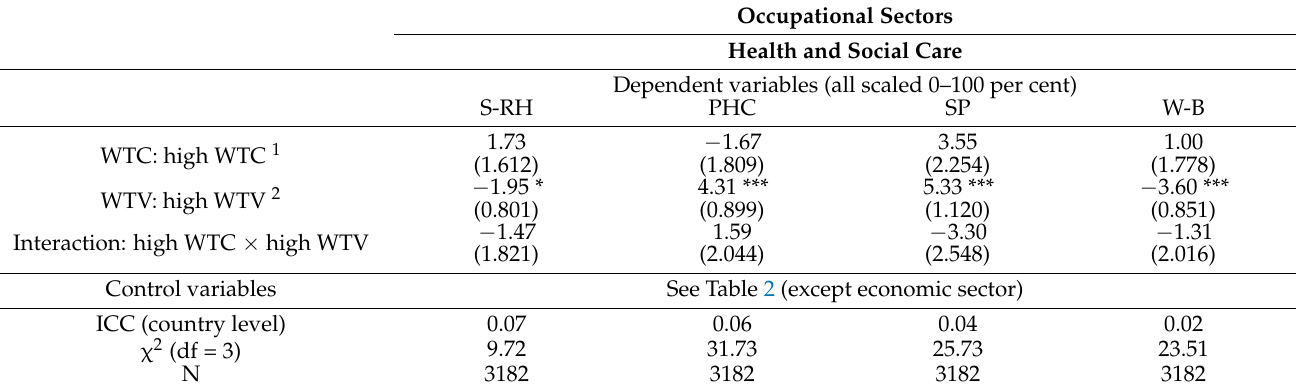
Table A5. Results for occupational sectors, part II (health and social